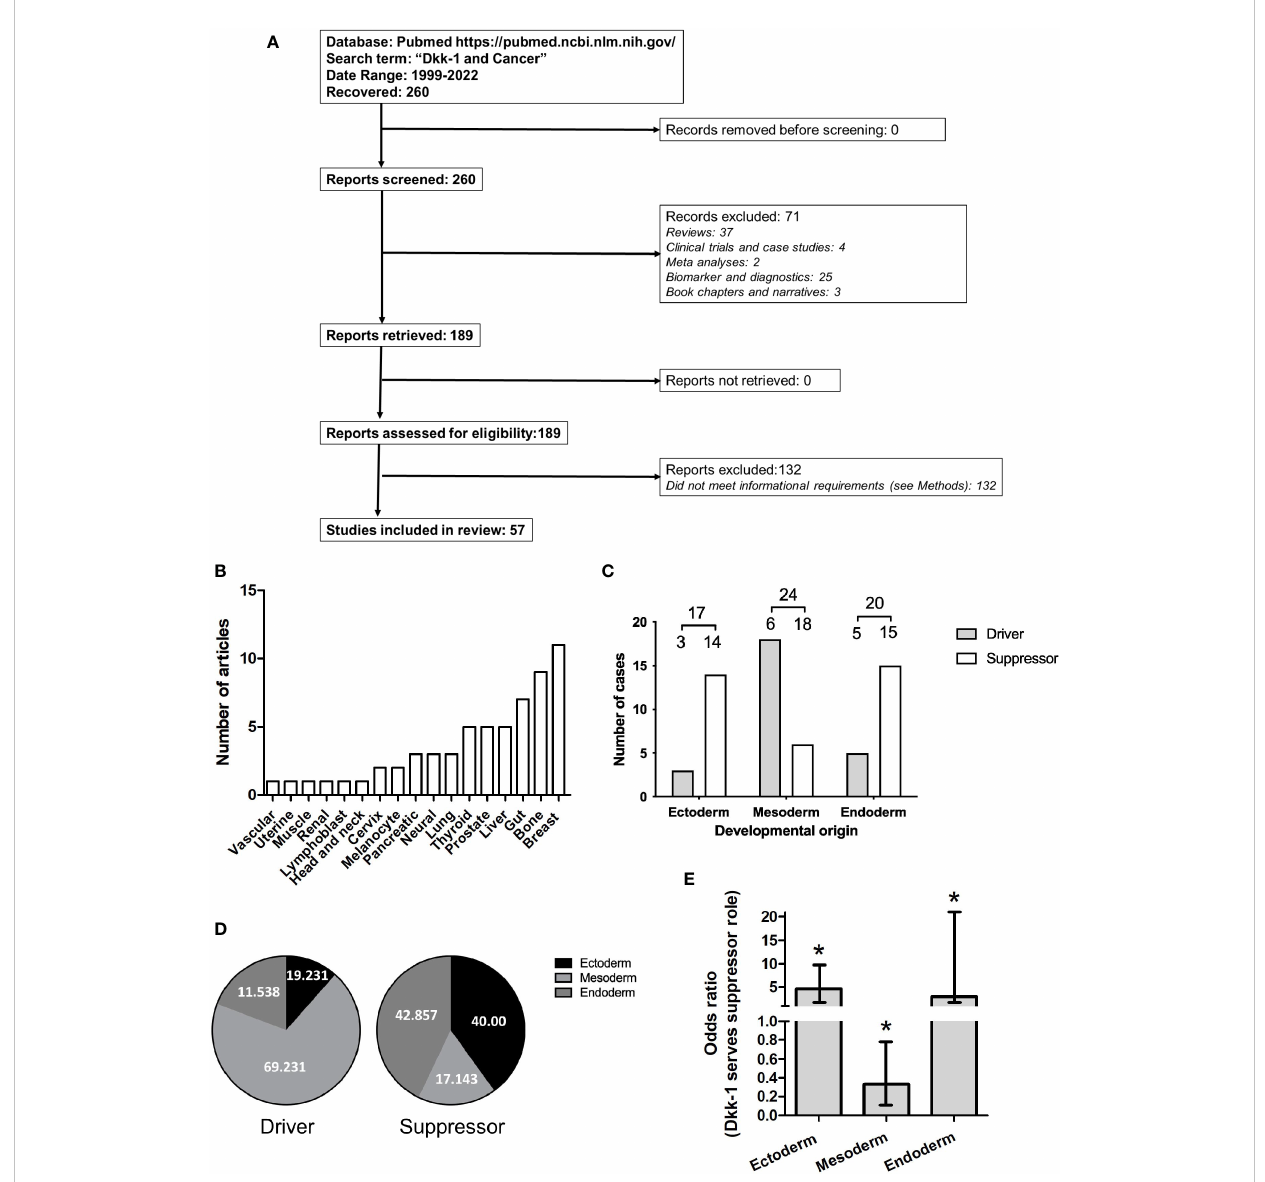
FIGURE 1 Dataset employed for systematic review of driver or suppressor status by Dkk-1 in tumors. (A) : PRISMA fl ow chart summarizing data curation. (B) : Frequency Tumor types covered by the dataset. (C) : Tumor types categorized based on developmental origin of the tumor and driver or suppressor status. Numbers are greater than the number of articles evaluated due to dual classi fi cation of some tumors. (D) : Distribution of data based on developmental origin of tumor and driver or suppressor status. (E) : Plot of odds ratios for Dkk-1 adopting a tumor suppressor role for each of the developmental layers. Error bars represent 95% con fi dence intervals and asterisk represents p <